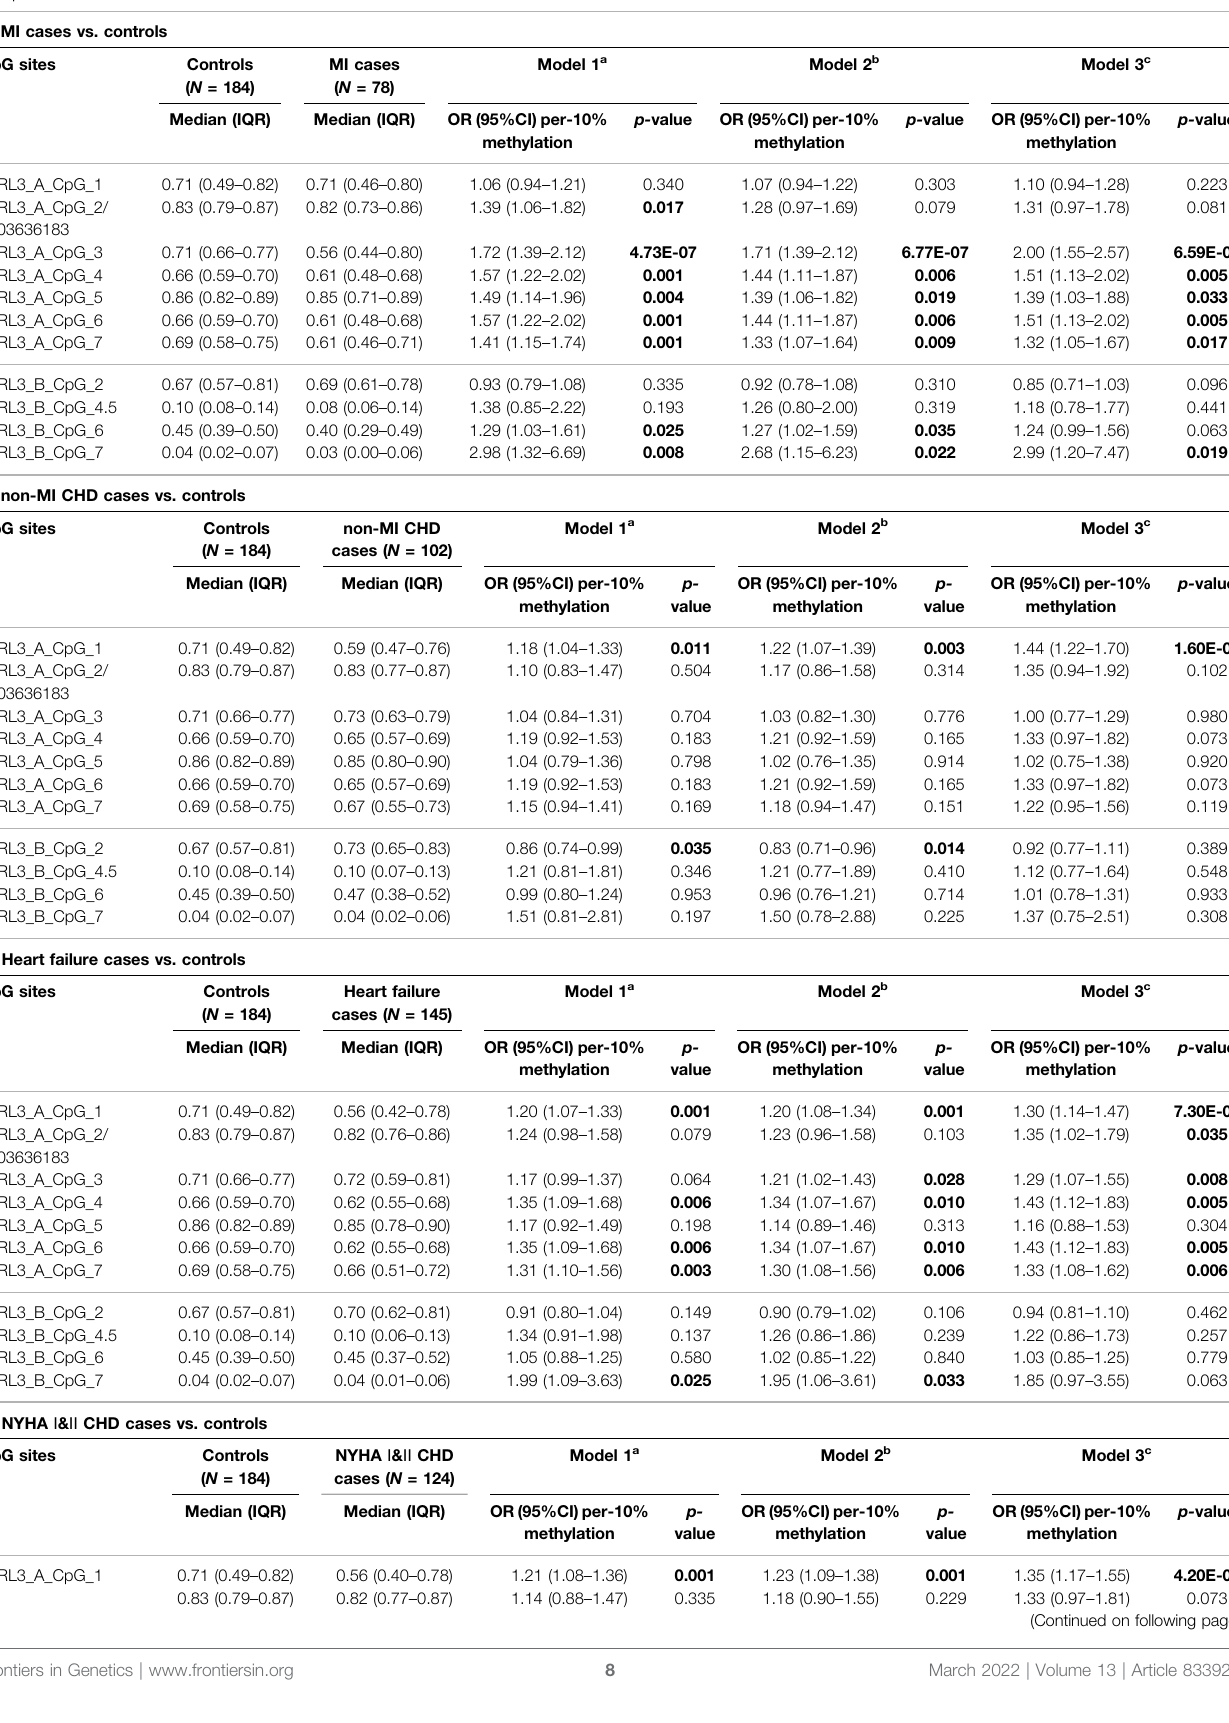
TABLE 3 | F2RL3 methylation in MI cases, non-MI CHD cases, heart failure cases, and patients with minor to medium cardiac function impairment (NYHA Ⅰ & Ⅱ CHD cases) compared to